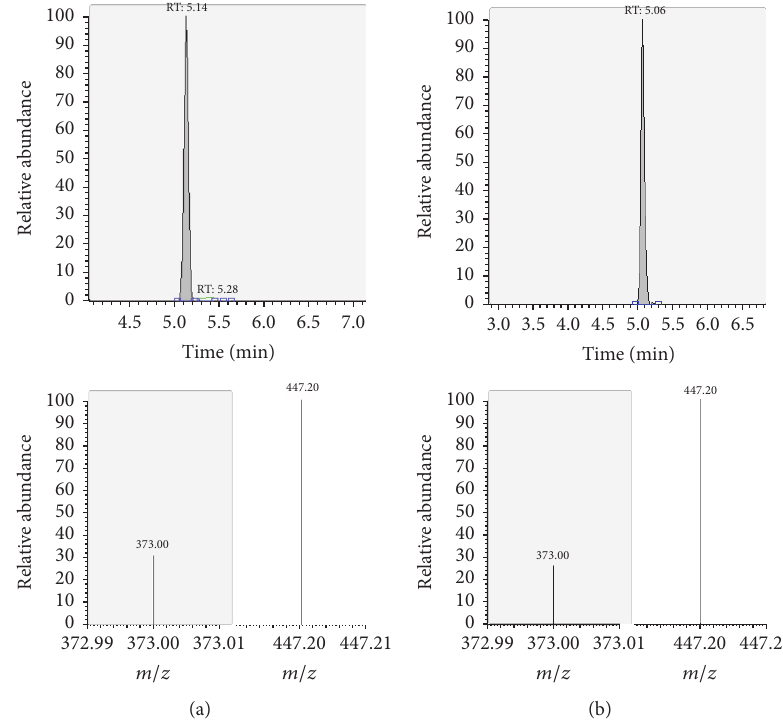
Figure9:LC-MS/MSchromatogramsofCLPandSRMtransitionsandrelativeabundances.(a)Standardina100 𝜇 gL −1 solution.(b)Standard in the spiked sample at 100 mgkg −1